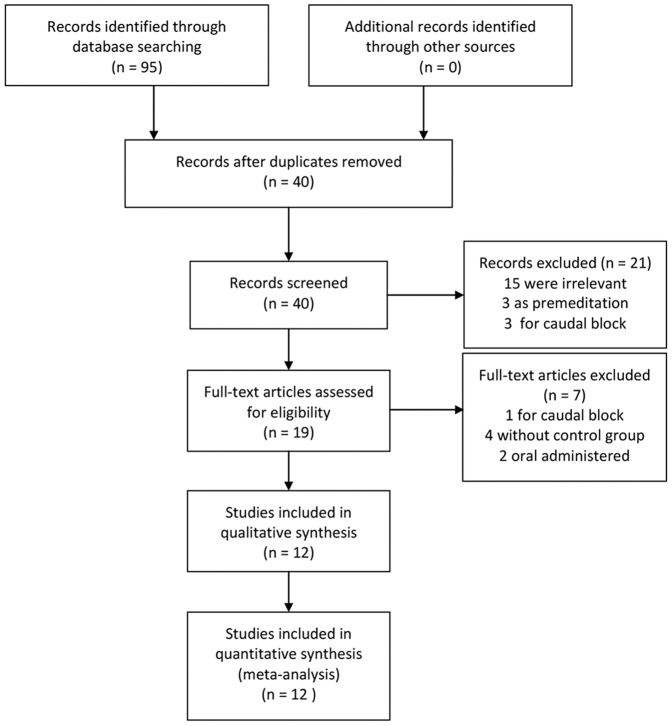
Flow chart of meta-analysis.